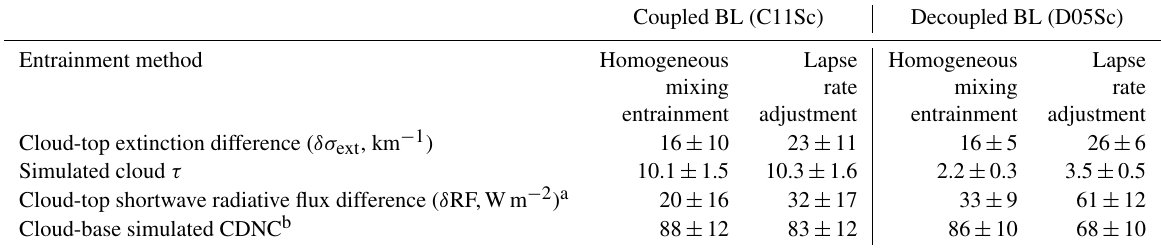
Table 3. Results of the application of entrainment fraction and the measured lapse rate entrainment parameterization for two clouds with observed cloud-top entrainment.